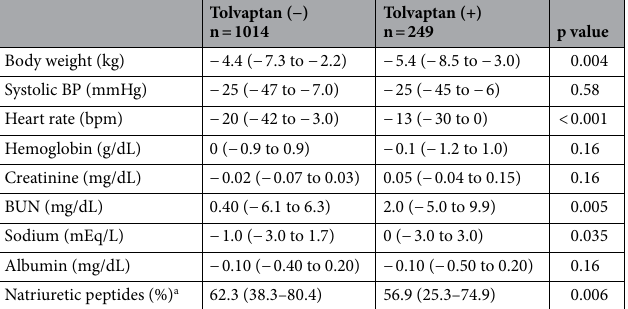
Table 2. Changes in clinical variables during the index hospitalization. a The change in natriuretic peptide (NP) levels, including either B-type natriuretic peptide or N-terminal pro-B-type natriuretic peptide, was defined as ([NP values at admission − NP values at discharge]/NP values at